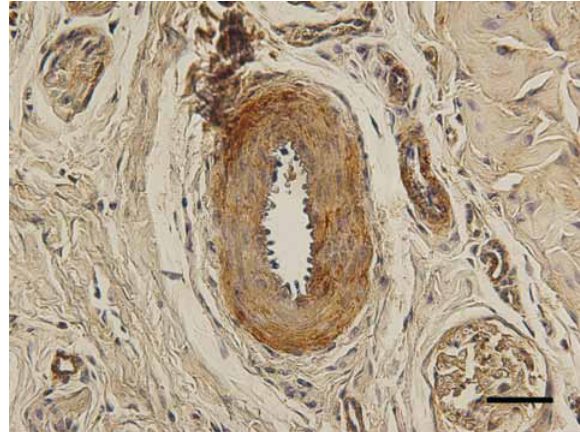
Figure 3 - Immunostaining of the smooth muscle in the tunica media of the DAP of rabbits from the control group. Sections were stained with the anti-alpha-actin antibody, and images were taken at 400x magnification. Scale bar: 50µm.